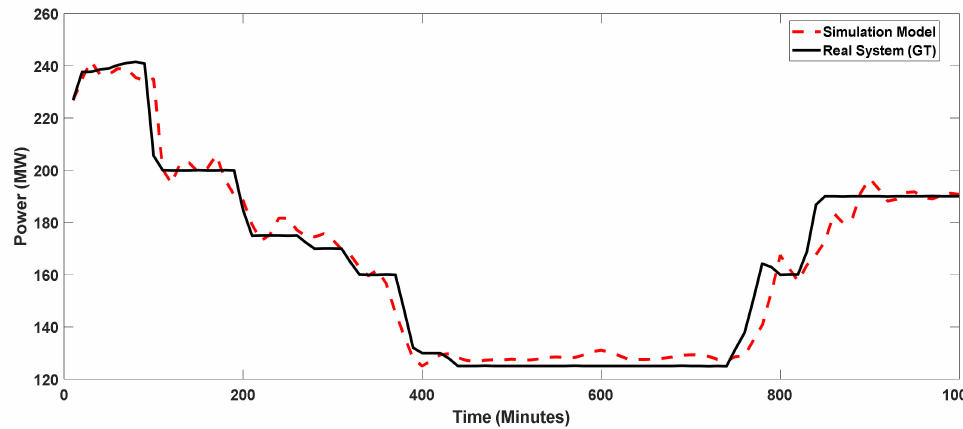
Figure 7. Measured and simulated GT